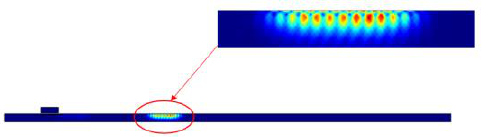
Figure 24. Acoustic field distribution of surface wave propagation depth. Fig. 23 Sound field distribution of surface wave propagation depth in aluminum plate